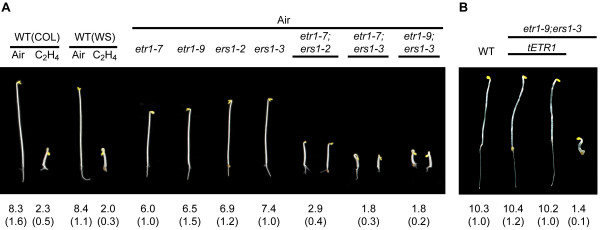
The etr1-7;ers1-3 and etr1-9;ers1-3 mutants exhibit a severe constitutive ethylene-response phenotype in dark-grown seedlings. (A)Effect of single and double mutations of subfamily 1 receptors upon seedling growth. etr1-7 was isolated from ecotype Columbia (Col), whereas etr1-9, ers1-2, and ers1-3 were isolated from ecotype Wassilewskija (WS). Both Col and WS wild-type seedlings are included as controls. Seedlings were grown in the dark for 3.5 days in the absence (air) or in the presence of ethylene (10 μL/L). AVG (5 μM) was included in growth media to inhibit ethylene biosynthesis by the seedlings. Mean hypocotyl lengths are given in millimeters with SD in parentheses. (B) Rescue of the constitutive ethylene-response phenotype of etr1-9;ers1-3 by transformation with wild-type ETR1 (tETR1). Phenotypes of 4-day-old seedlings are shown for a wild-type control, the etr1-9;ers1-3 mutant line, and two independent lines of etr1-9;ers1-3 transformed with tETR1.